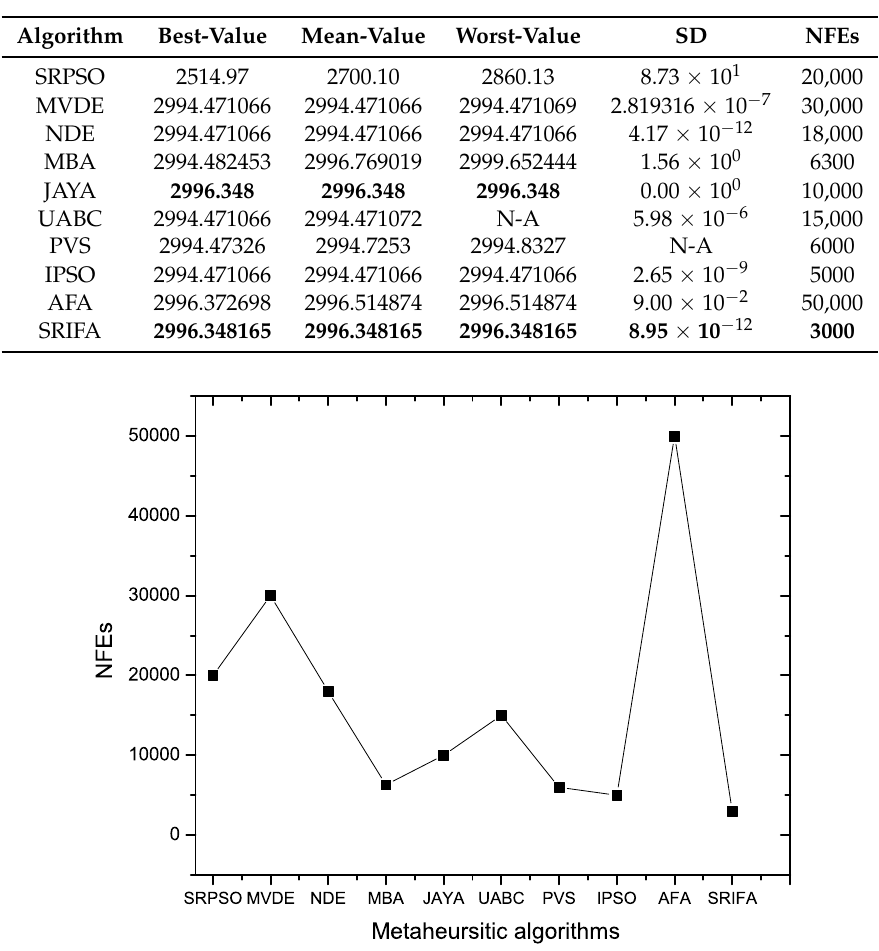
Table 15. Statistical results of comparison between SRIFA and NIAs for the speed-reducer problem.